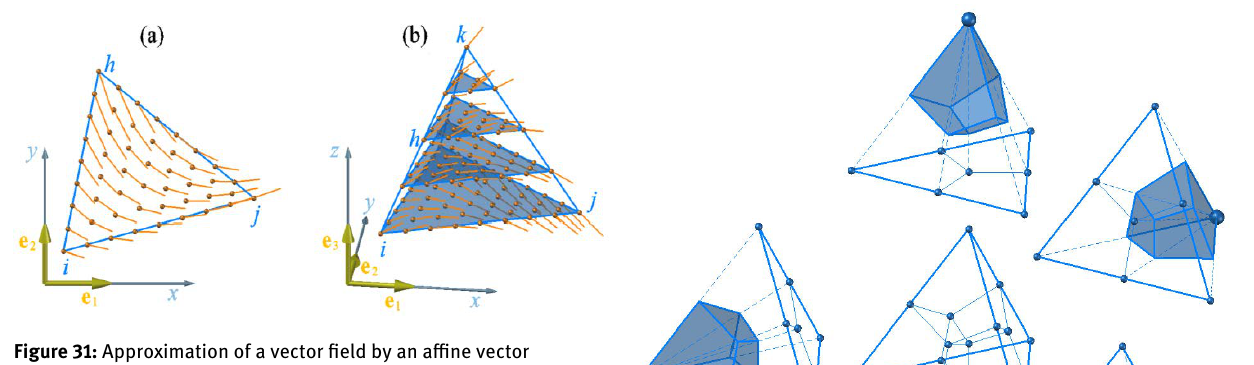
Figure 31: Approximation of a vector field by an aflne vector field defined by the vectors at the vertices of a triangle, in two- dimensional space (a), and of a tetrahedron, in three-dimensional space (b).